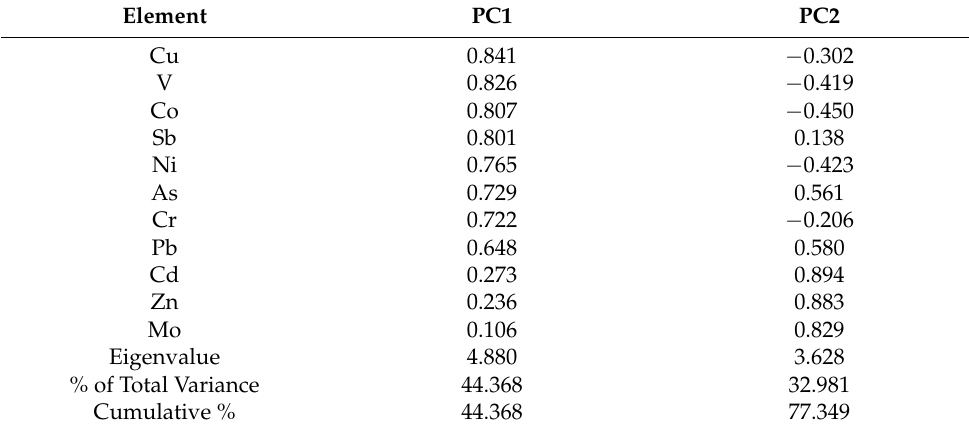
Table 4. Analysis of the main components of heavy metals in sediments.